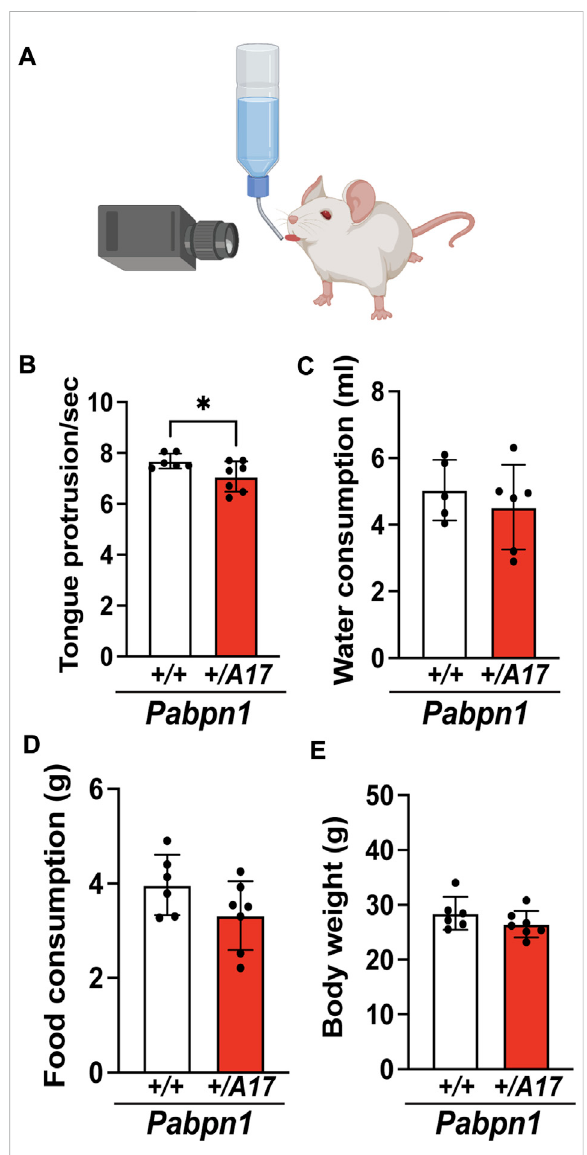
FIGURE 1 Pabpn1 +/A17 mice exhibit functional pharyngeal muscle defects. (A) Illustration of lick assay used to measure swallow function in mice. (B) Number of tongue protrusions per second is signi fi cantly decreased in Pabpn1 +/A17 mice as counted by video analysis of lick assay. (C,D) No difference of daily water consumption (ml) (C) and daily food consumption (G)(D) between Pabpn1 +/+ mice and Pabpn1 +/A17 mice were measured. (E) Body weight was not different between Pabpn1 +/+ mice and Pabpn1 +/A17 mice. Shown is mean ± SEM for n = 6 – 7 mice per